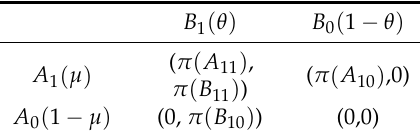
Table 2. Pay-off